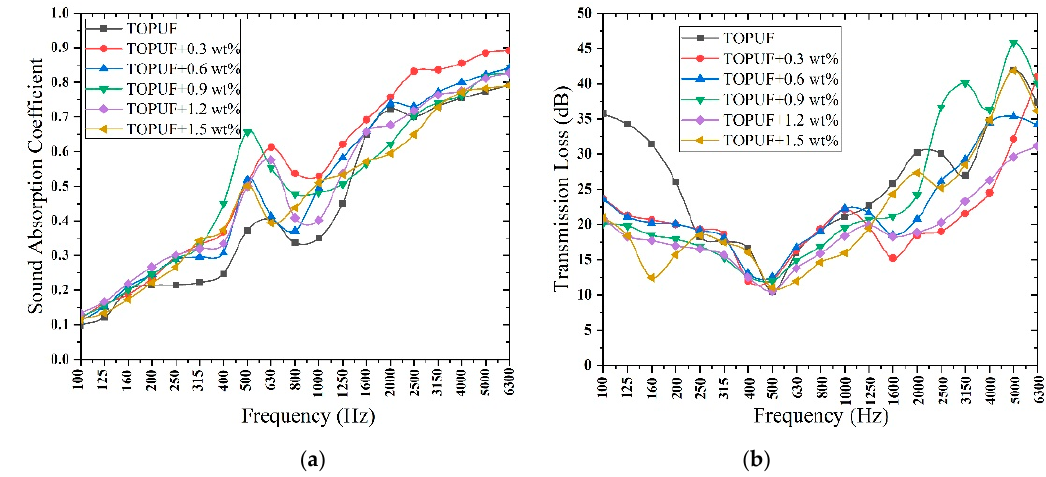
Figure 11. Sound absorption ( a ) and transmission loss ( b ) of TOPUF adding different mass of ML powders.